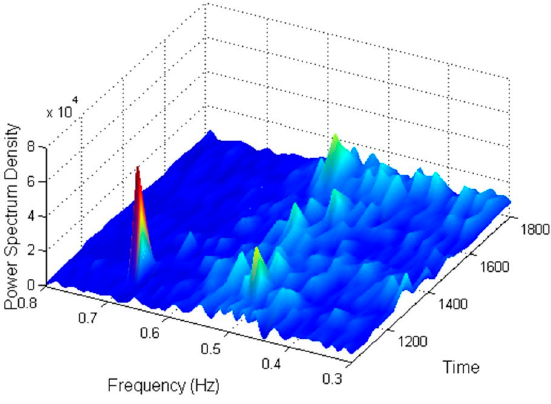
Figure 10. Power spectral density of the power flow measured during the rolling blackout.